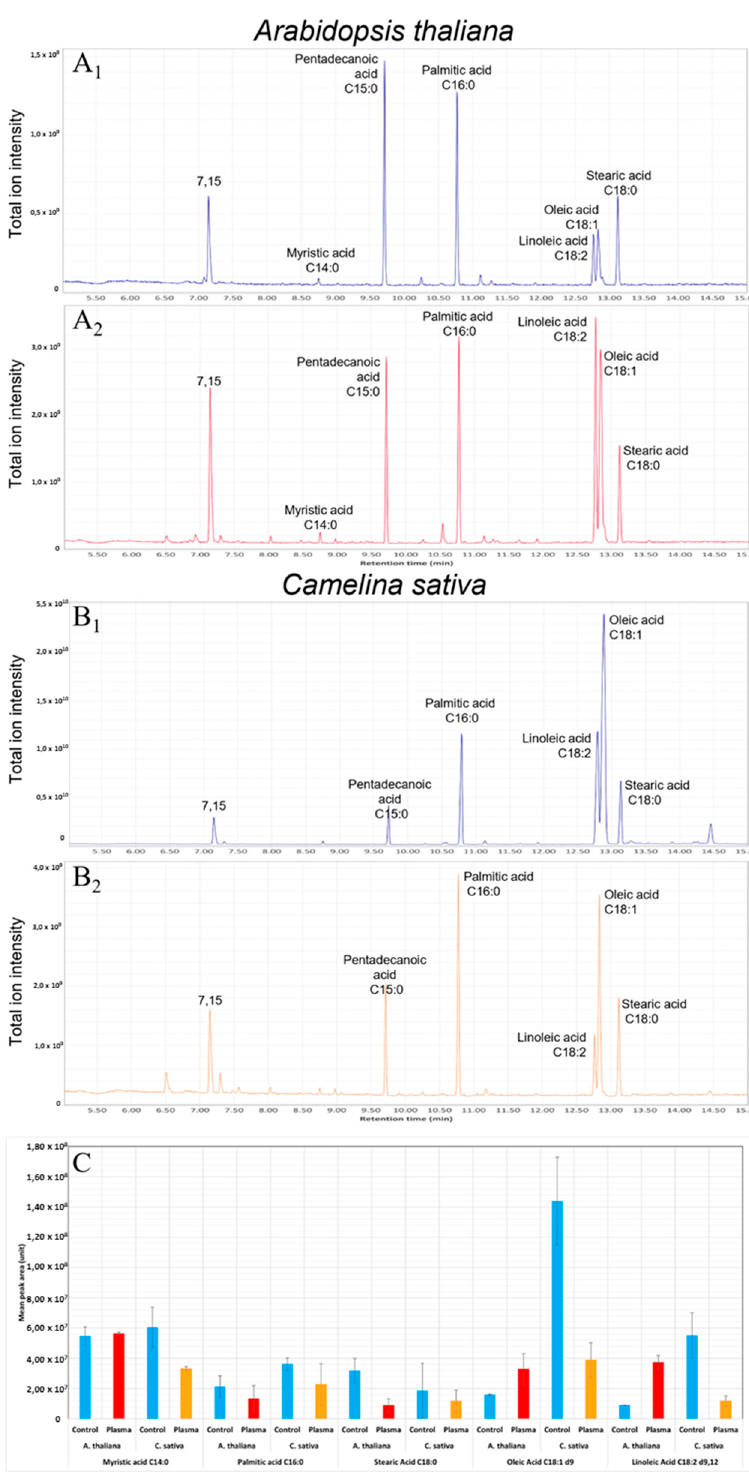
Figure 6 . Change of free fatty acid composition on the surface of A. thaliana and C. sativa in the case of the control, the plasma seeds treated 1 min ( C. sativa ) and 15 min ( A. thaliana ). In blue, the analysis of the control seeds, in red, the treated A. thaliana seeds, and in orange, the treated C. sativa seeds. ( A ) GC/MS spectra of A. thaliana extract, ( 1 ) control seeds, ( 2 ) 15 min plasma treated seeds. ( B ) GC/MS spectra of C. sativa extract, ( 1 ) control seeds, ( 2 ) 1 min plasma treated seeds. ( C ) analysis of three samples, the relative abundance is calculated as a function of the C15 proportion used as a standard. All unsaturation places are noted as follows: “d”.